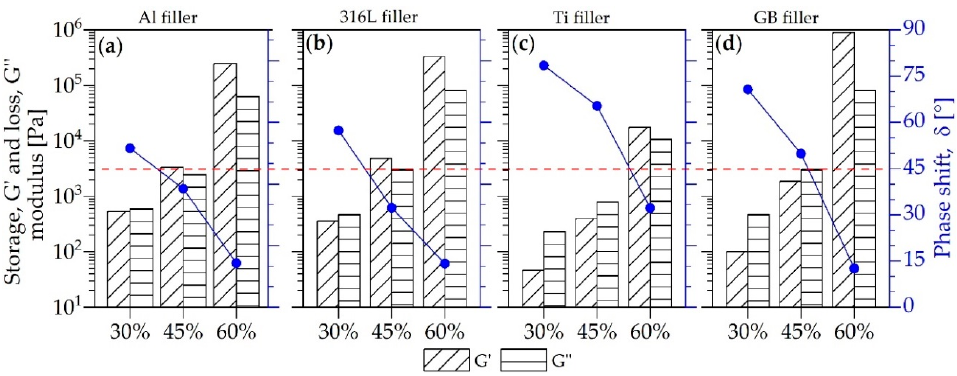
Figure 4. Storage, G ′ , loss, G ″ modulus, and phase shift, δ at constant γ = 0.05%, 175 °C, and at 6.28 rad/s for the fillers: ( a ) Al, ( b ) 316L, ( c ) Ti, and ( d ) GB.